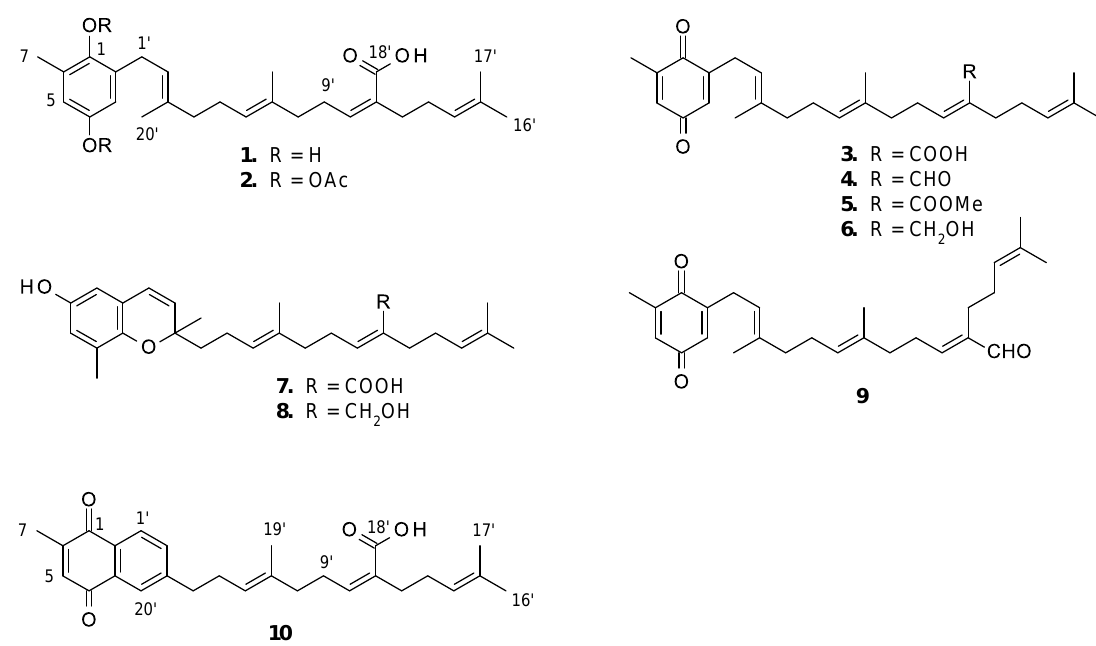
Figure 1. Natural and semi-synthetic derivatives of sargahydroquinoic acid ( 1 ).